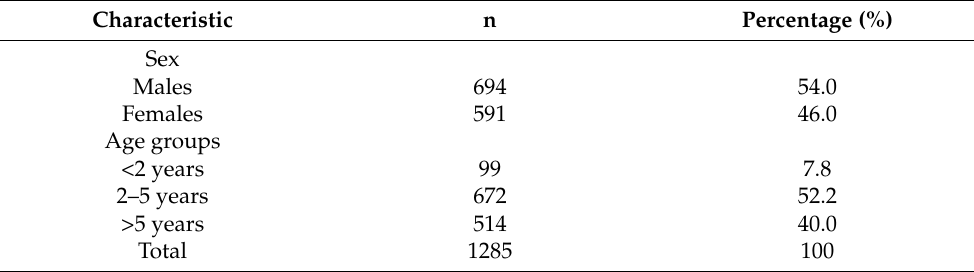
Table 1. Demographic